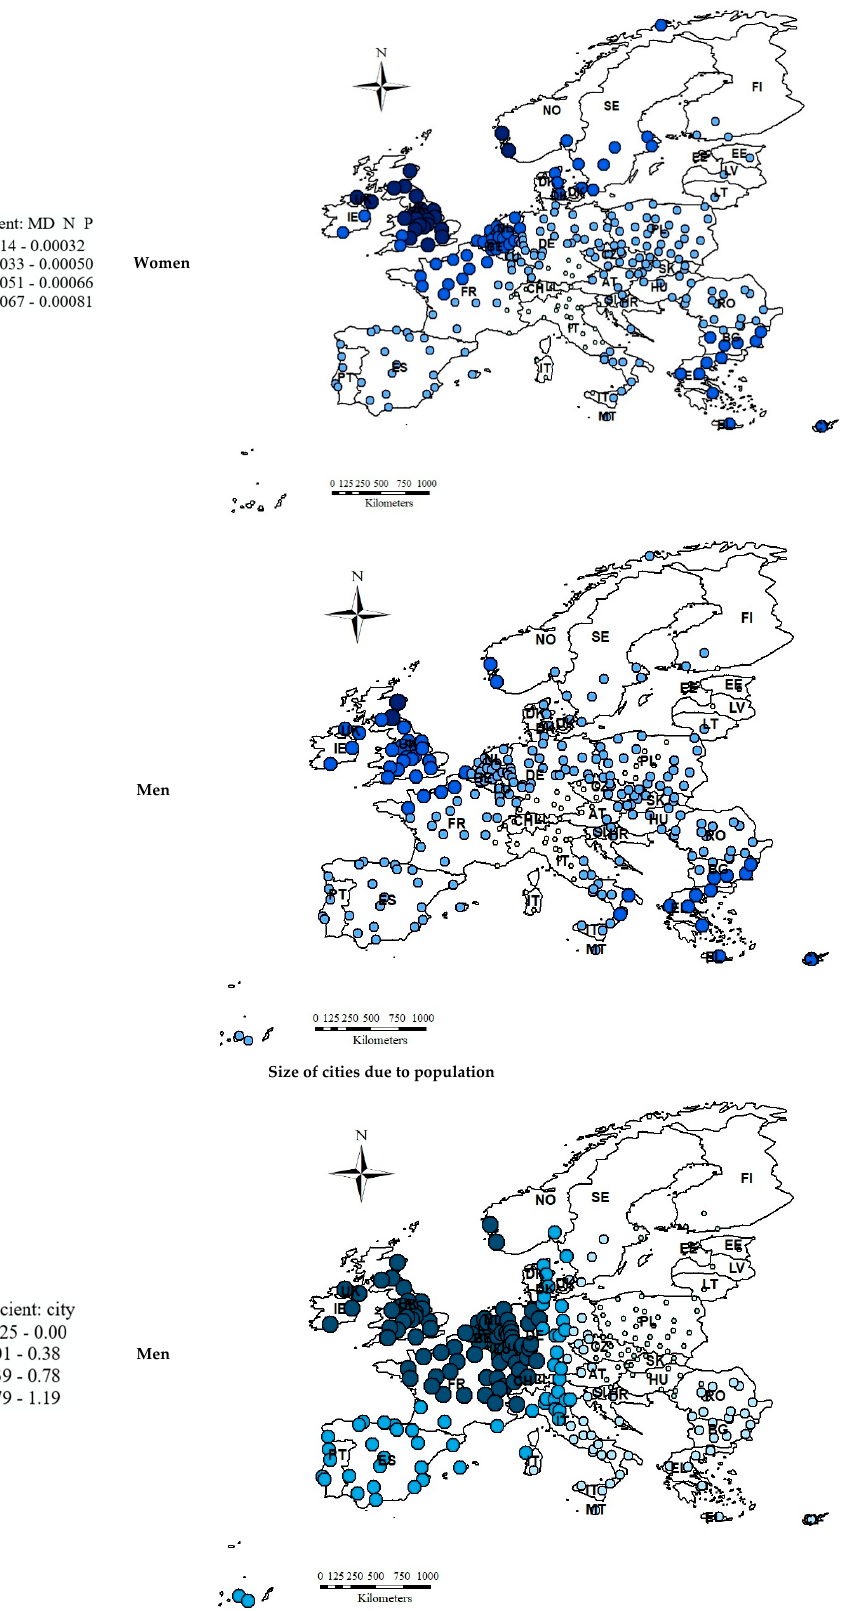
Figure 4. Local values of coefficients in the GWR models. Source: Own elaboration in ArcGIS (ArcMap 10.5).